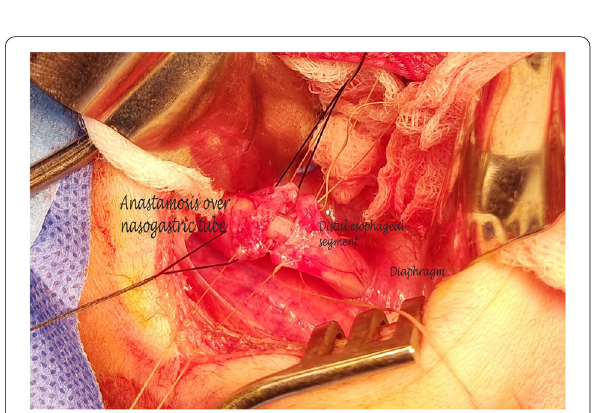
Fig. 5 Intra-op view of cord connection between two ends of the esophagus